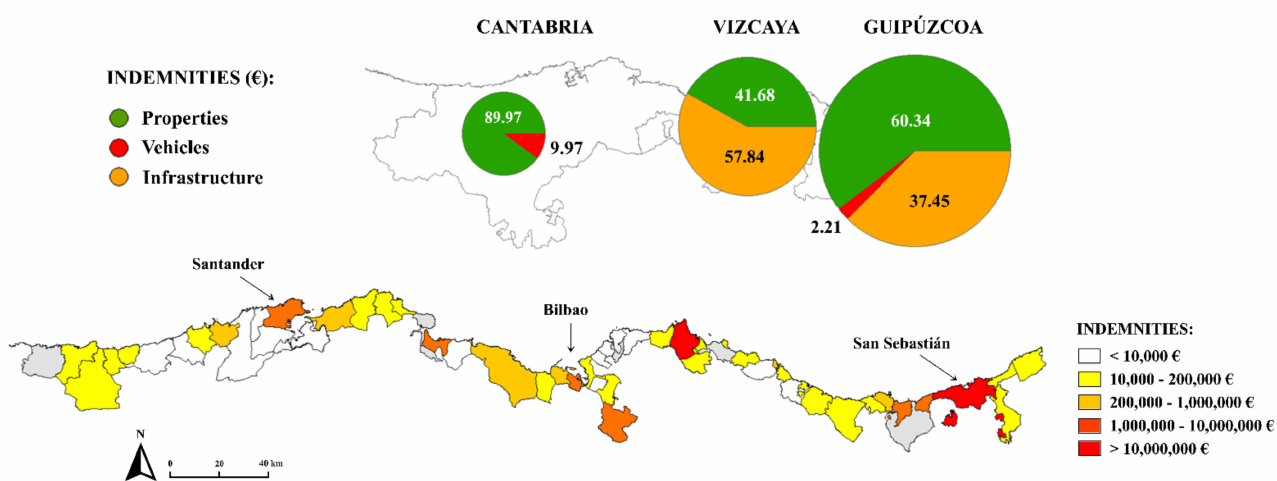
Figure 7. Percentage of damage and dates of the 10 most relevant storm damage events during the time span analyzed.